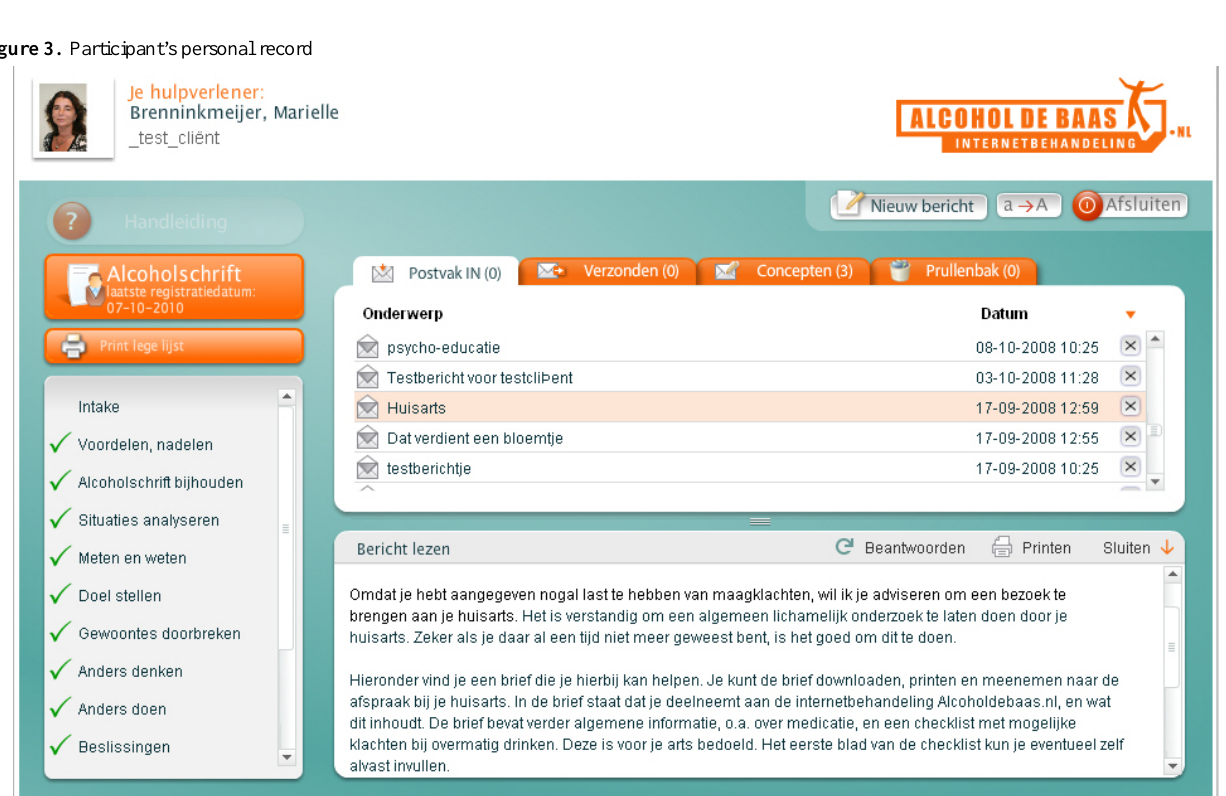
Figure 3. Participant’s personal